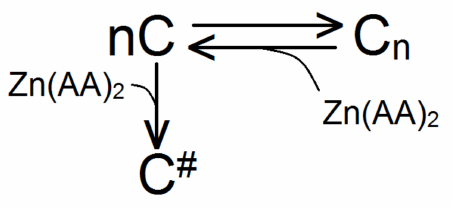
Figure 6. Scheme of cell transitions of bacterial culture in the presence of zinc chelate complex, C—single cell, C n —cellular associates of bacterial culture, C # —dead